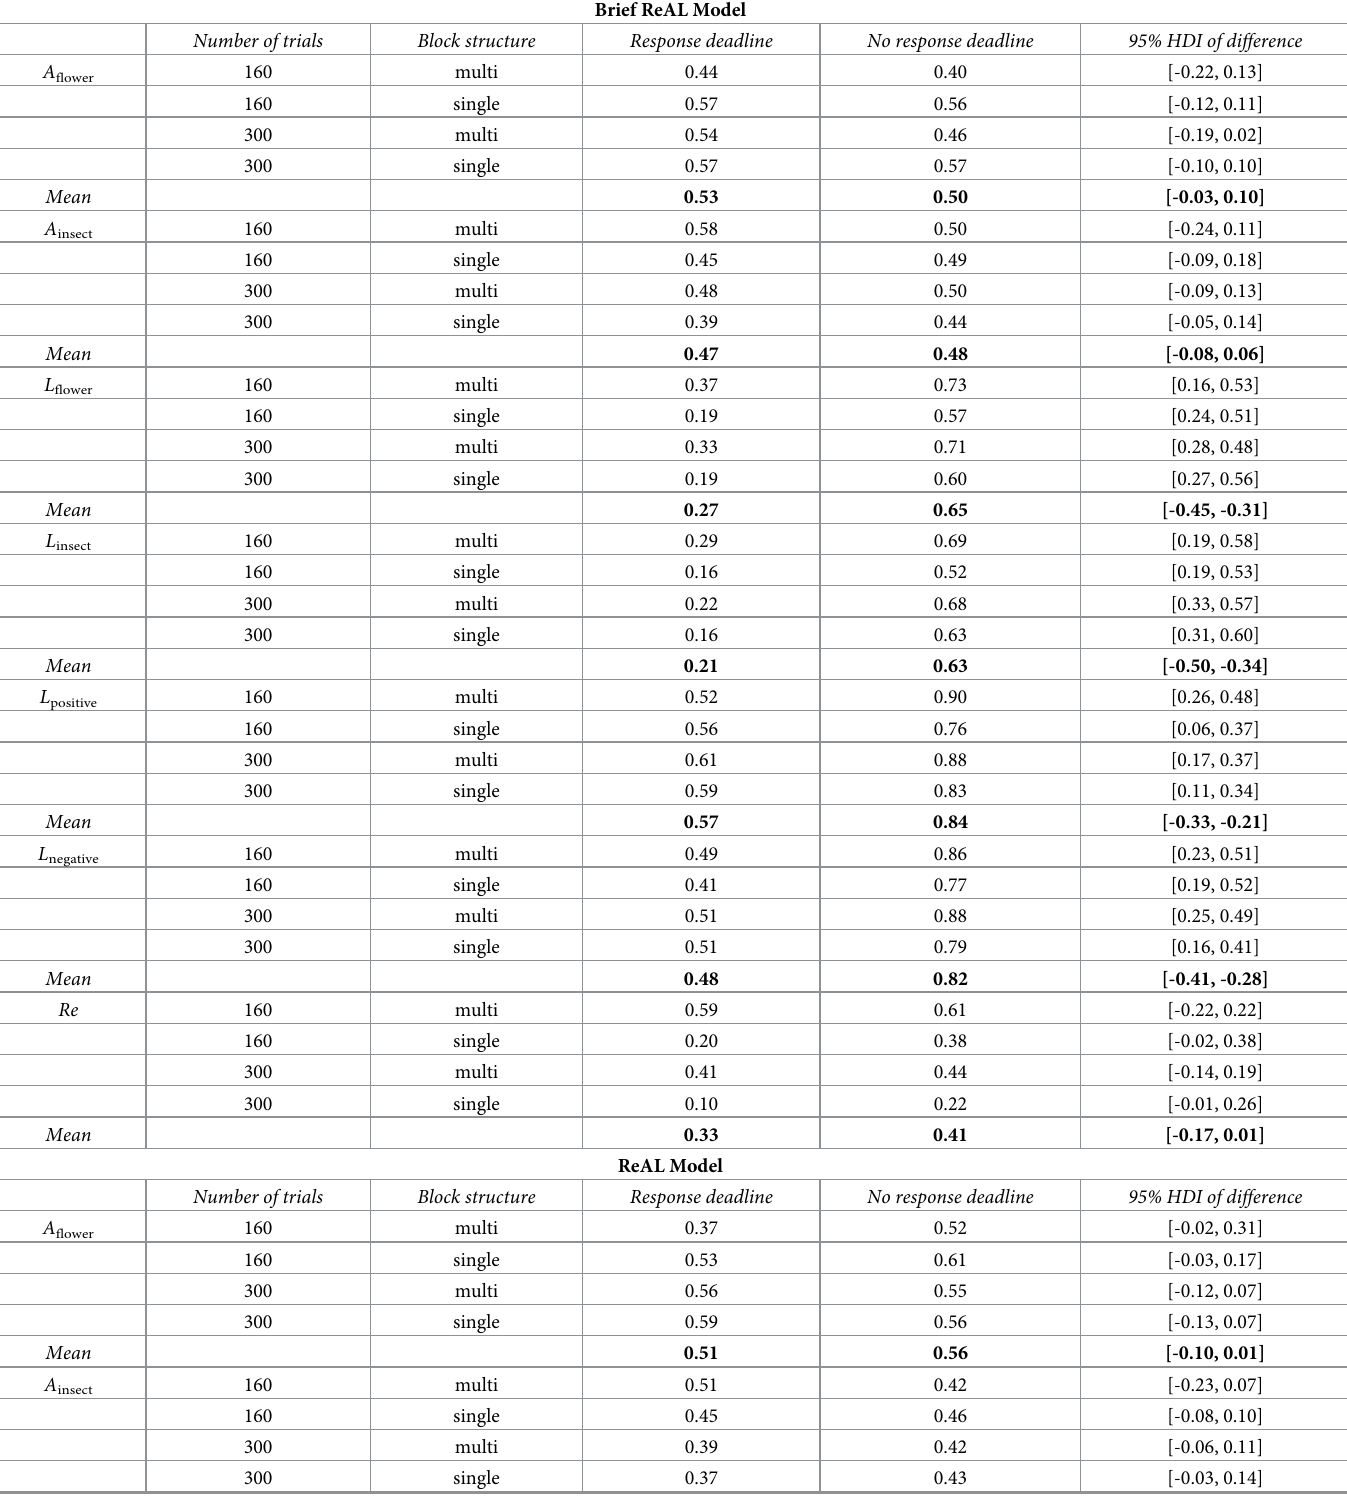
Table 5. Mean parameter estimates from IATs with versus without response